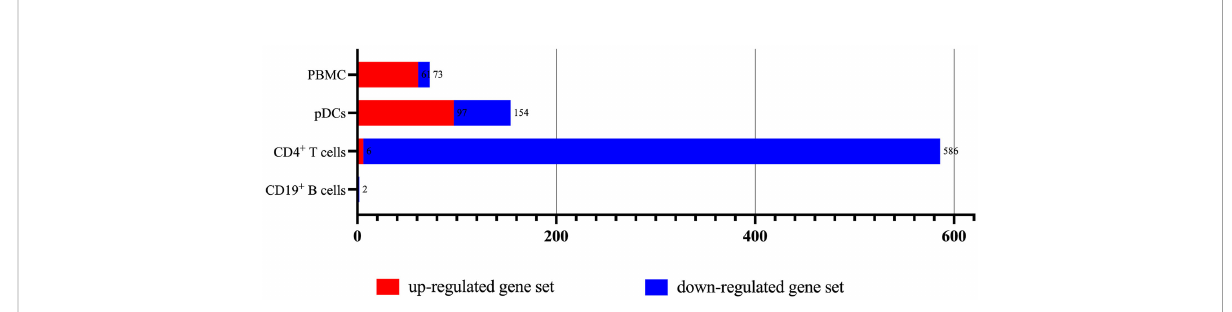
FIGURE 2 The types of up-regulated and down-regulated target genes for CD19 + B cells, CD4 + T cells, pDCs, and PBMC in MS patients treated with Fingolimod or IFN- b